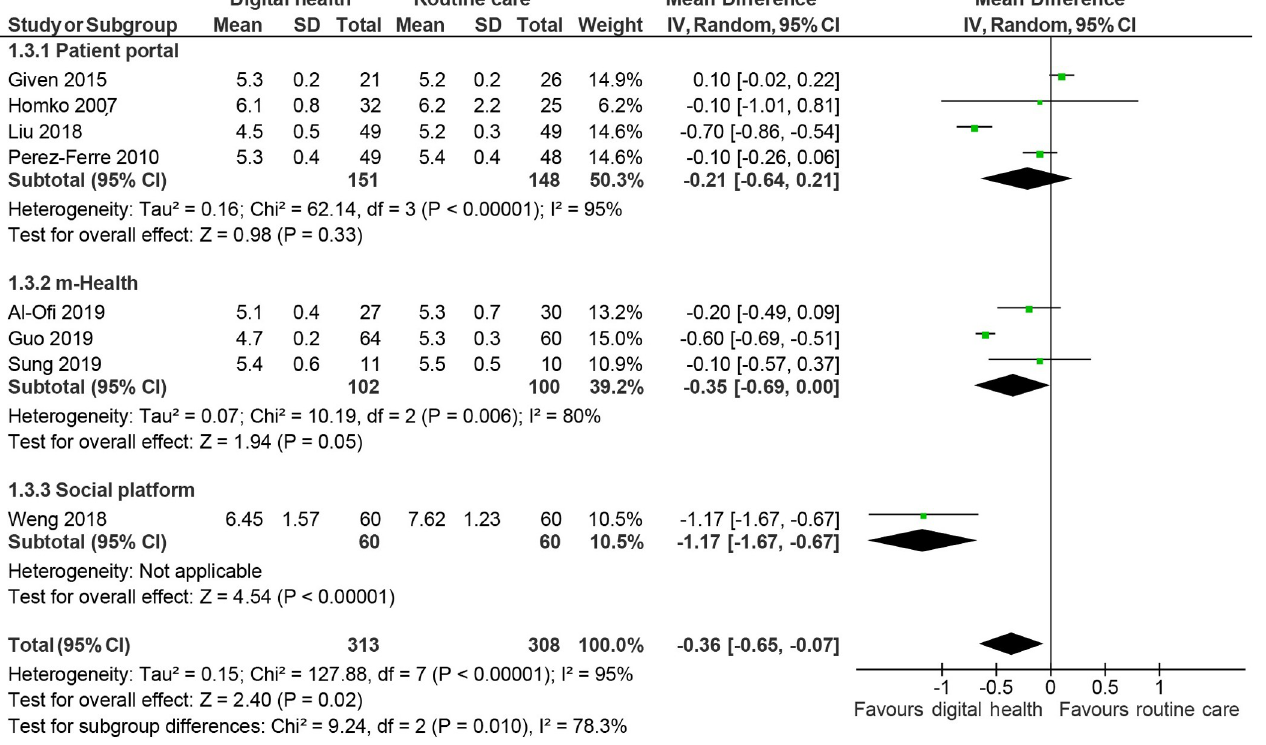
Fig 4. Random effects meta-analysis of the mean difference in HbA1c (%), comparing digital health interventions or routine care.